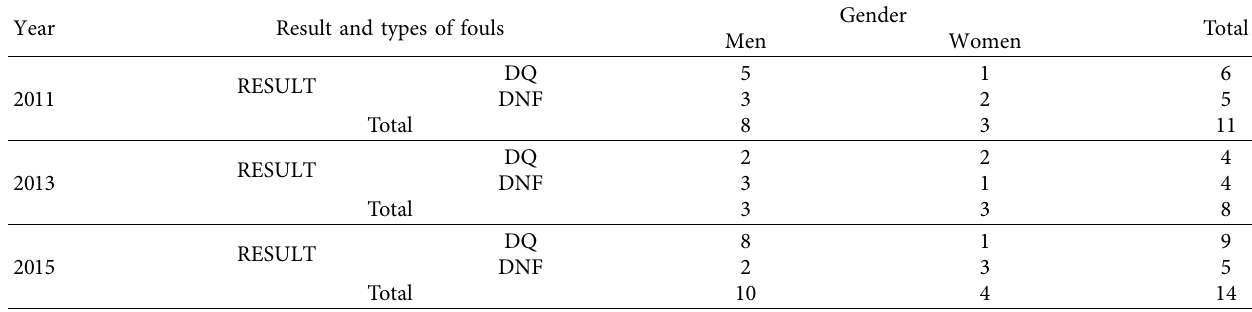
Table 7: Contingency table of foul type and gender.